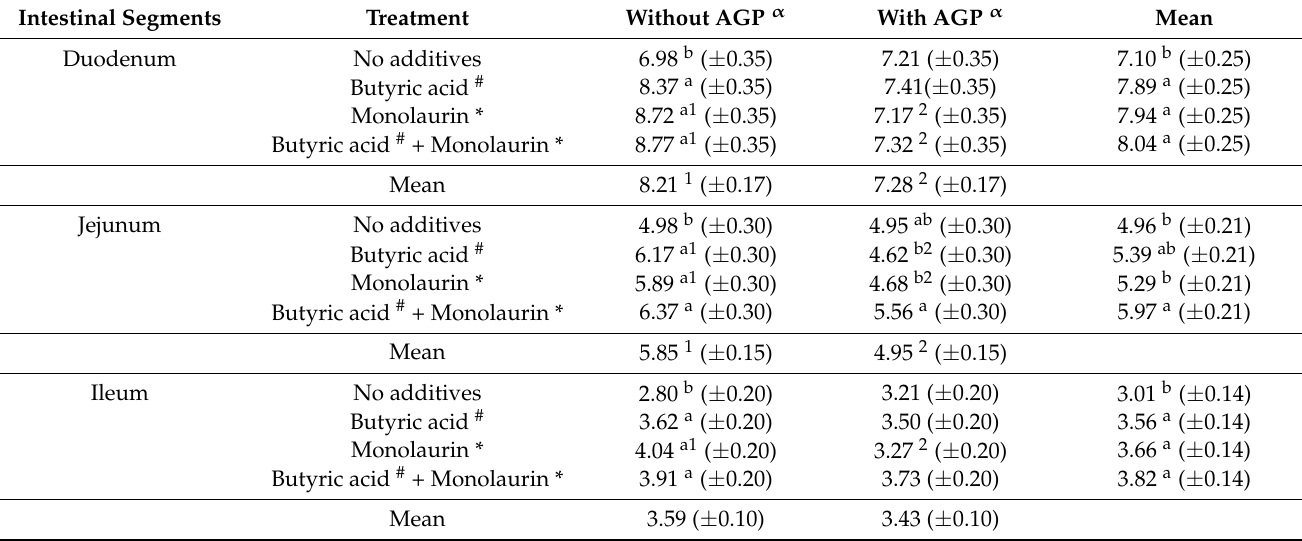
Table 8. The effect of butyric acid and α -monolaurin, with and without the inclusion of antibiotic growth promoters, on VH:CD ratio of the duodenum, jejunum and ileum of broilers at 20 days of age ( ± standard error of the mean). Intestinal Segments